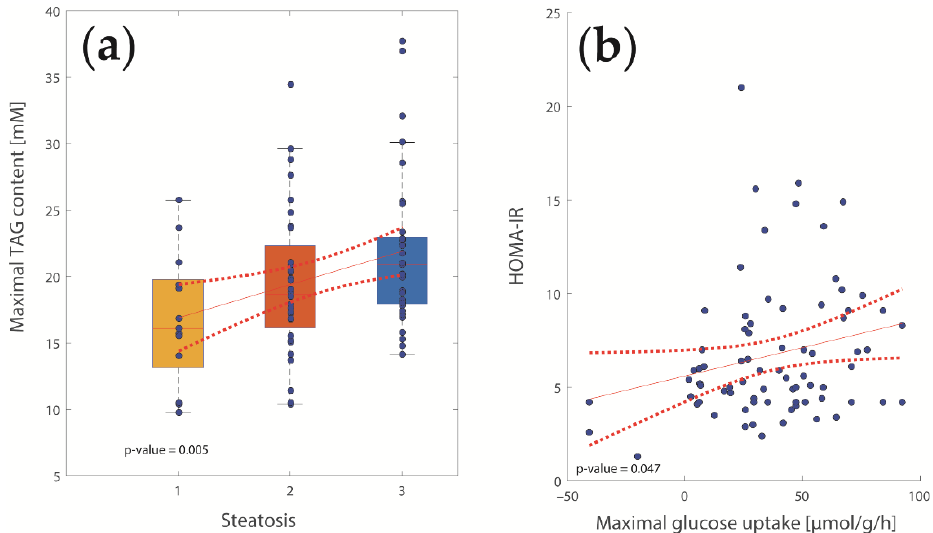
Figure 1. Model validation. ( a ) Relationship between hepatic triacylglycerol (TAG) content and histologically assessed grade of steatosis; ( b ) Relationship between homeostatic model assessment for insulin resistance (HOMAR-IR) and hepatic glucose uptake.